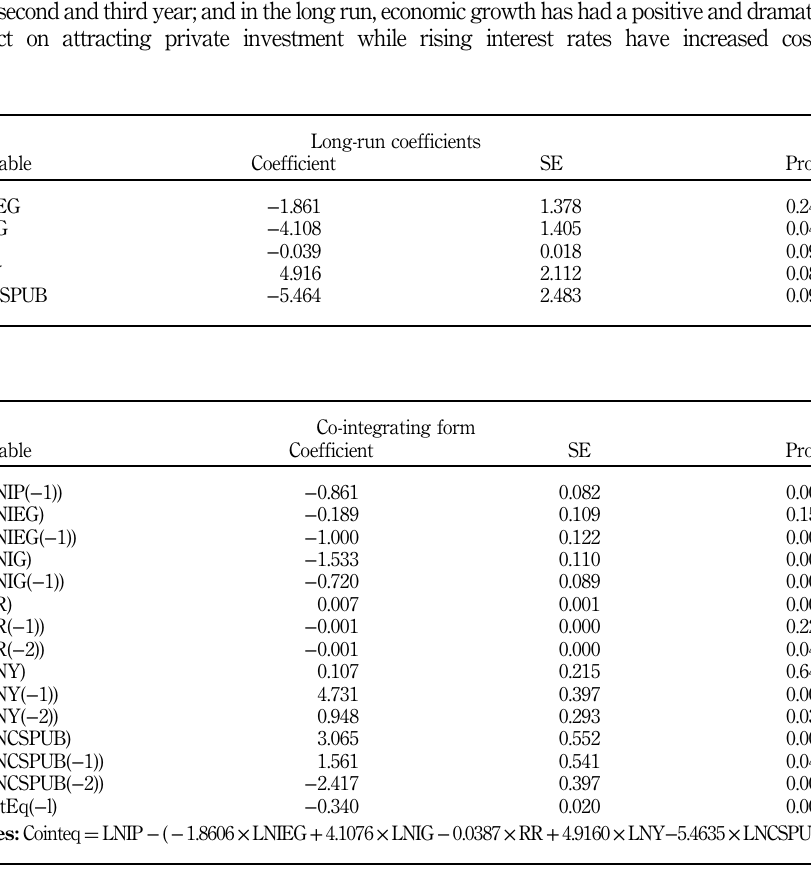
Table XII. In the long run, public investment, state-owned capital stock, and real interest rates have a negative impact on private investment. In contrast, in the long run, real economic growth has a strong impact and attracted private investment growth.